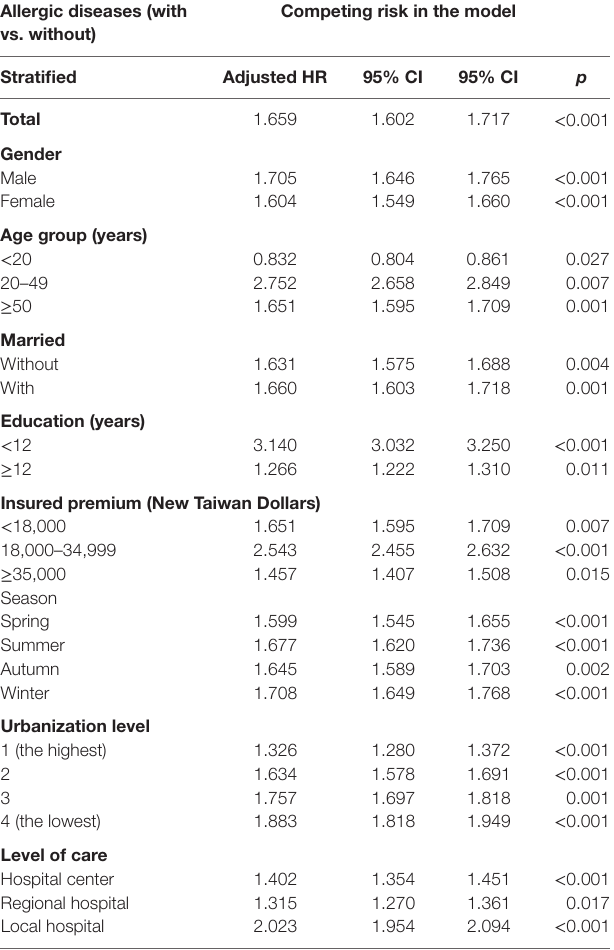
TaBle 6 | Factors of psychiatric disorders stratified by variables listed in the table by using Fine and Gray’s competing risk model. allergic diseases (with vs. without)